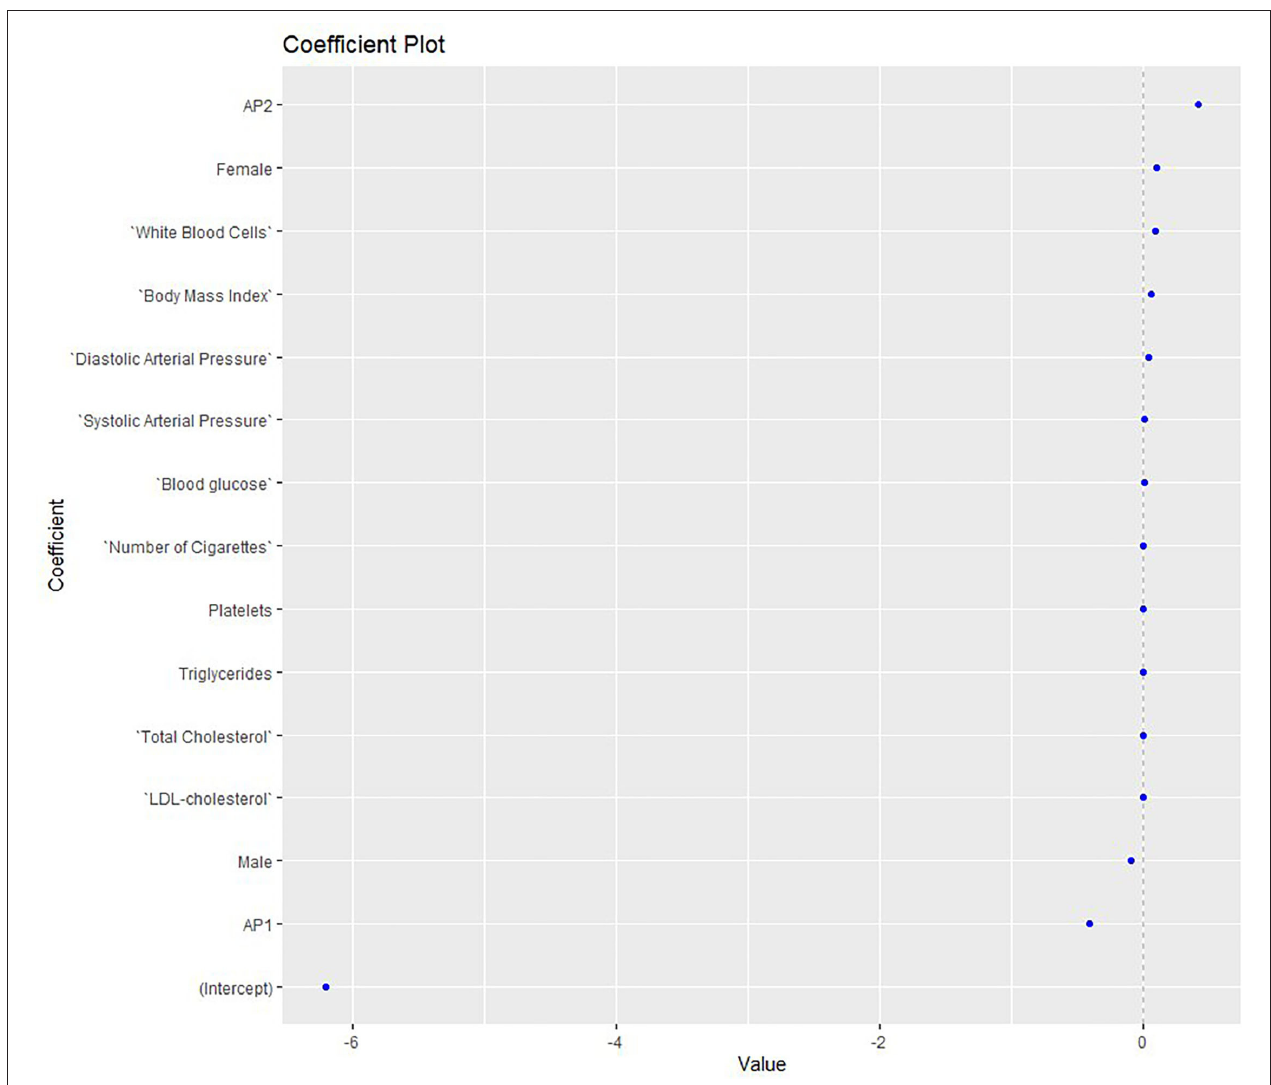
FIGURE 2 | Elastic net model exploring the MetS risk in relation to gait parameters measured with PODOSmart ®, along with anthropometric, clinical and biochemical markers. AP, antipsychotics; LDL, low-density